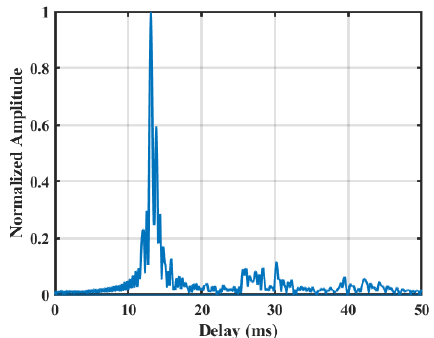
Figure 6. Measured channel (ChB) for simulation.